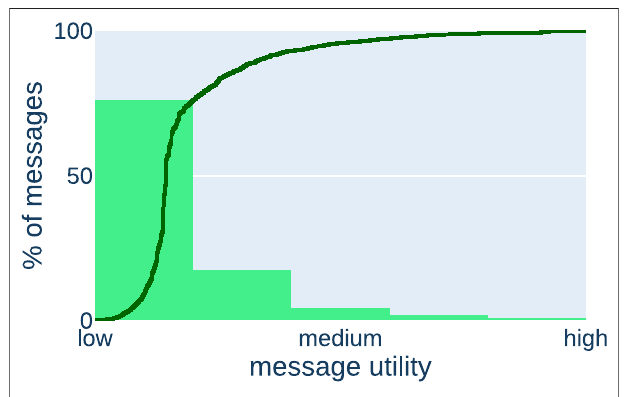
FIGURE 4 | Characteristics of the proof of concept, which show that a random algorithm would not perform well in this setting as most of the messages are of low utility.